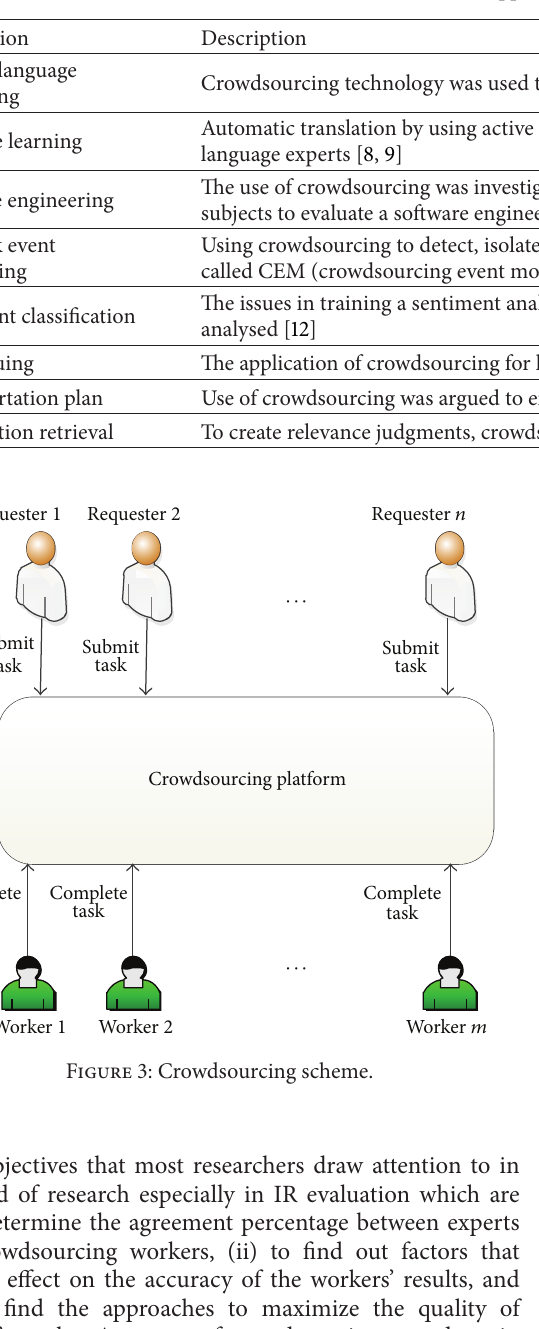
Table 2: Different applications of crowdsourcing.